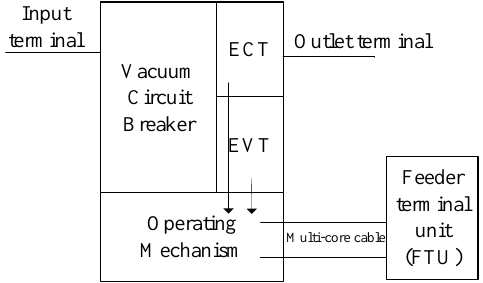
Figure 1. Structure diagram of primary and secondary integration distribution switch.